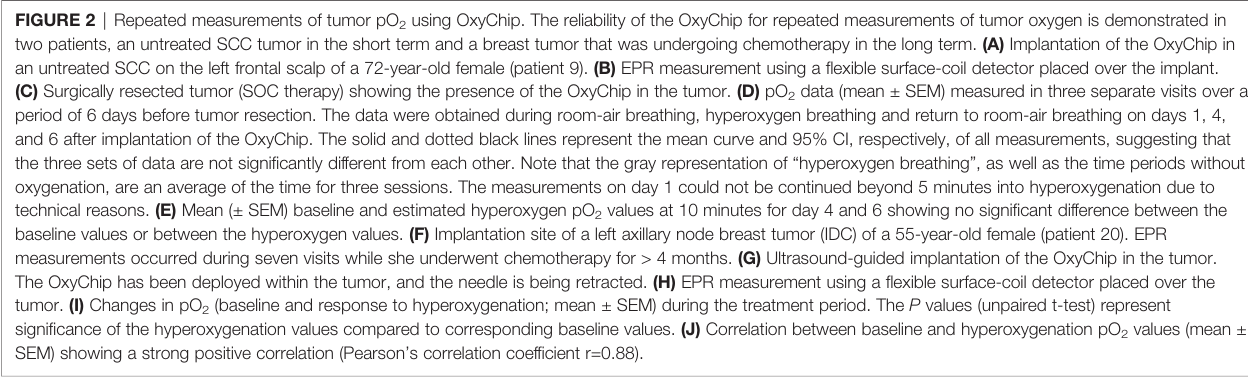
FIGURE 2 | Repeated measurements of tumor pO 2 using OxyChip. The reliability of the OxyChip for repeated measurements of tumor oxygen is demonstrated in two patients, an untreated SCC tumor in the short term and a breast tumor that was undergoing chemotherapy in the long term. (A) Implantation of the OxyChip in an untreated SCC on the left frontal scalp of a 72-year-old female (patient 9). (B) EPR measurement using a fl exible surface-coil detector placed over the implant. (C) Surgically resected tumor (SOC therapy) showing the presence of the OxyChip in the tumor. (D) pO 2 data (mean ± SEM) measured in three separate visits over a period of 6 days before tumor resection. The data were obtained during room-air breathing, hyperoxygen breathing and return to room-air breathing on days 1, 4, and 6 after implantation of the OxyChip. The solid and dotted black lines represent the mean curve and 95% CI, respectively, of all measurements, suggesting that the three sets of data are not signi fi cantly different from each other. Note that the gray representation of “ hyperoxygen breathing ” , as well as the time periods without oxygenation, are an average of the time for three sessions. The measurements on day 1 could not be continued beyond 5 minutes into hyperoxygenation due to technical reasons. (E) Mean (± SEM) baseline and estimated hyperoxygen pO 2 values at 10 minutes for day 4 and 6 showing no signi fi cant difference between the baseline values or between the hyperoxygen values. (F) Implantation site of a left axillary node breast tumor (IDC) of a 55-year-old female (patient 20). EPR measurements occurred during seven visits while she underwent chemotherapy for > 4 months. (G) Ultrasound-guided implantation of the OxyChip in the tumor. The OxyChip has been deployed within the tumor, and the needle is being retracted. (H) EPR measurement using a fl exible surface-coil detector placed over the tumor. (I) Changes in pO 2 (baseline and response to hyperoxygenation; mean ± SEM) during the treatment period. The P values (unpaired t-test) represent signi fi cance of the hyperoxygenation values compared to corresponding baseline values. (J) Correlation between baseline and hyperoxygenation pO 2 values (mean ± SEM) showing a strong positive correlation (Pearson ’ s correlation coef fi